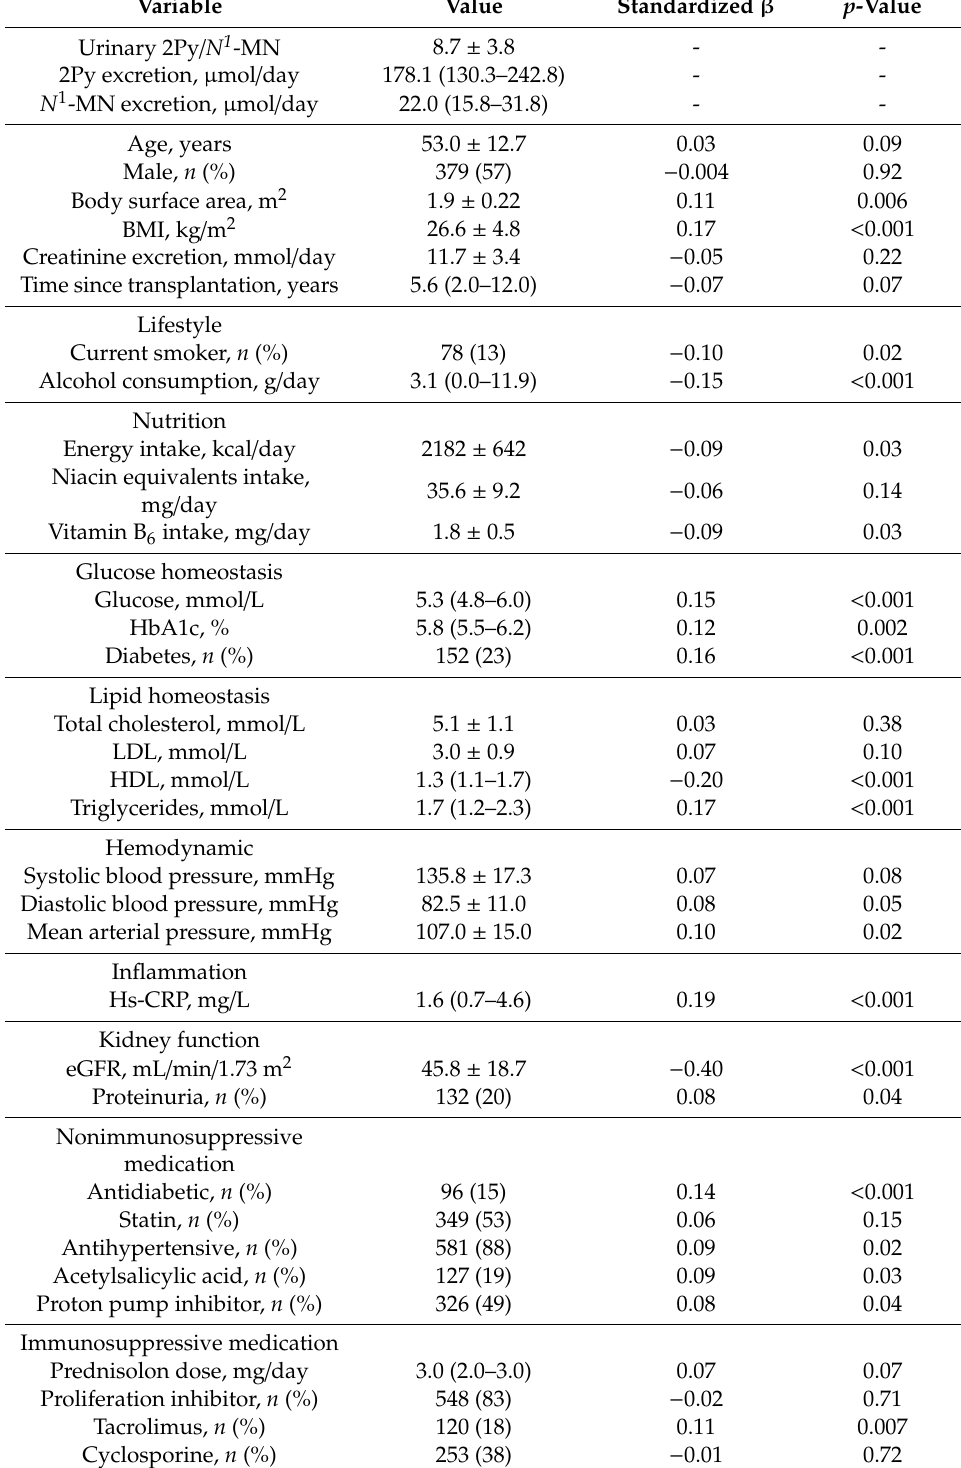
Table 3. Associations of urinary 2Py / N 1 -MN with characteristics in 660 RTR 1,2